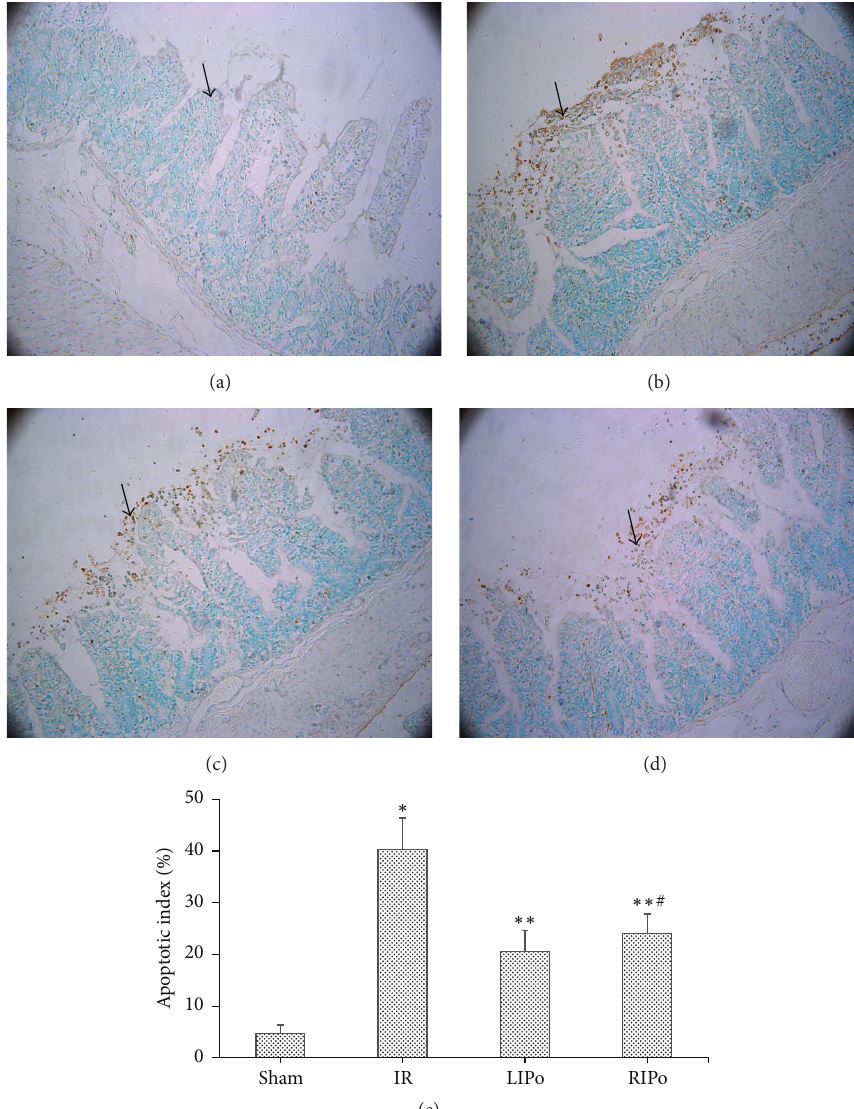
Figure 4: (e) Apoptotic indexes of each group (magnification 200x). Data were represented as mean ± SD, 𝑛 = 6 . ∗ 𝑝 < 0.05 versus the sham group; ∗∗ 𝑝 < 0.05 versus the I/R group; # 𝑝 > 0.05 versus the LIPo group.